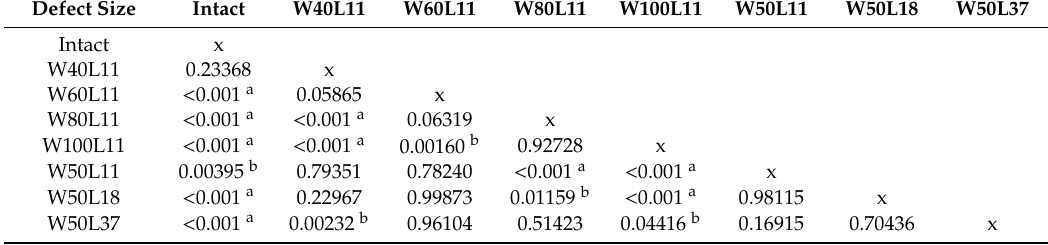
Figure 4. The bending stiffness decreases when a cortical window is created in the center of a sheep radius diaphysis, determined with a four-point bending test. The differences were not significant.